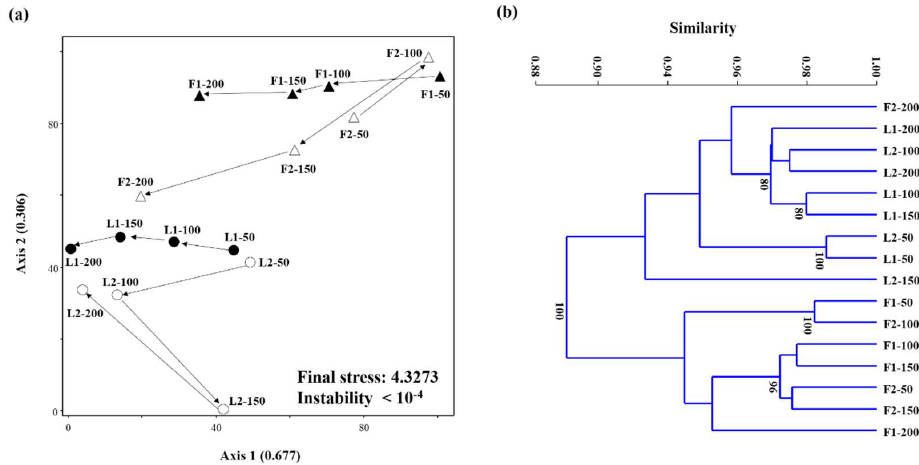
Figure 6. NMS plot ( a ) and cluster dendrogram ( b ) generated based on the archaeal HRM peak profiles from the residual Ulva biomass in the LBR and the filter biomass in the AF. Data points are labeled with the corresponding reactor names followed by WRRs. Bootstrap values higher than 70% (1000 replicates) are shown.